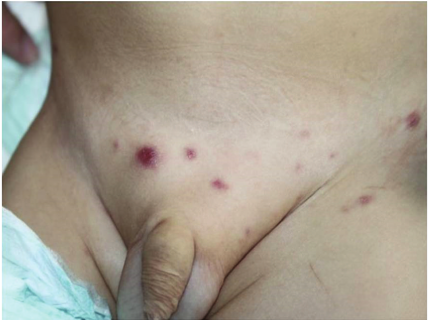
Figure 1: Papulosquamous lesions located in the inguinal region.